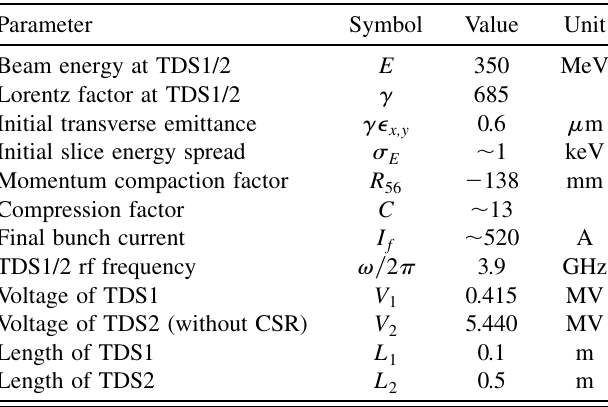
TABLE I. Parameters of the electron beam, of the bunch compressor system, and of the transverse deflecting rf